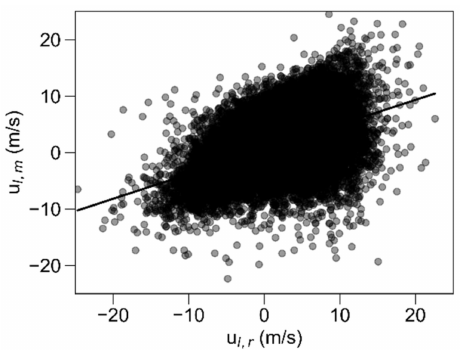
Figure A2. Correlation between reproduced and measured alongshore wind velocities. The black line represents the linear correlation estimated by the least-squares method.